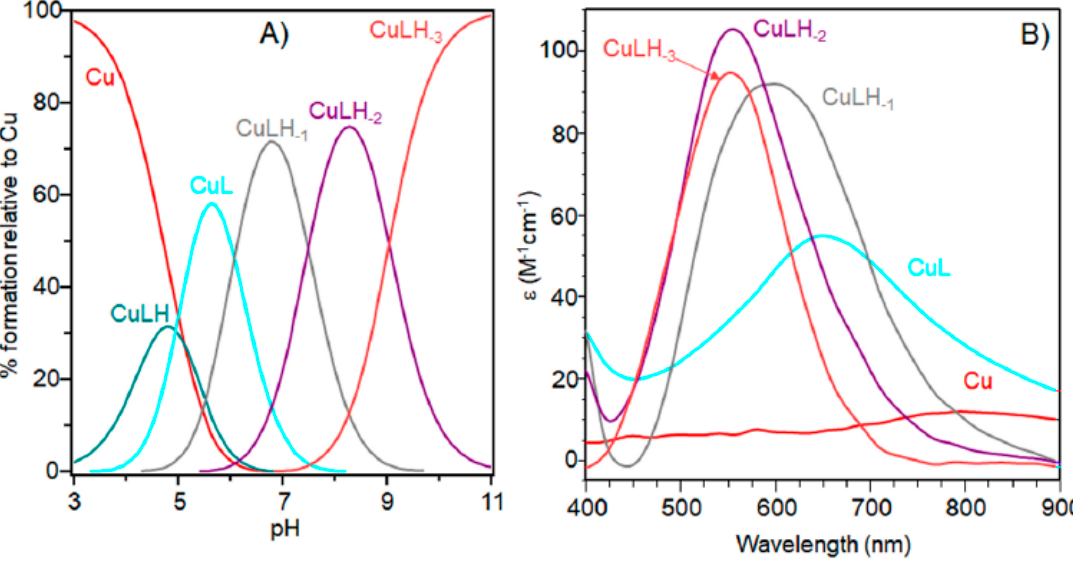
Figure 1. ( A ) Species distribution diagram for Cu-Ac-SLHHLPG-NH 2 complexes at 1:1 copper-to-ligand molar ratio; and ( B ) ultraviolet-visible (UV-vis) spectra calculated using the computational program HYPERQUAD. [L] = 1 × 10 − 3 M. For clarity, the charges on the speciation plots were omitted. The logK value (logK = log β 111 − log β 011 = 3.70) (Table 1) was higher than that generally reported